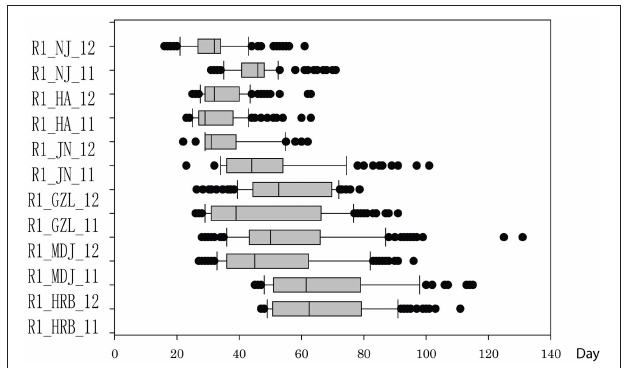
FIGURE 4 | Phenotypic variations in flowering time (R1) of cultivars or accessions at different locations and in 2011 and 2012. The phenotypic segregation is shown in box-plot format. The interquartile region, median, and range are indicated by the box, the bold horizontal line, and the vertical line, respectively. For location, HRB, Harbin; MDJ, Mudanjiang; GZL, Gongzhuling; JN, Jinan; HA, Huaian; NJ, Nanjing. For years, 11, 2011; 12, 2012.